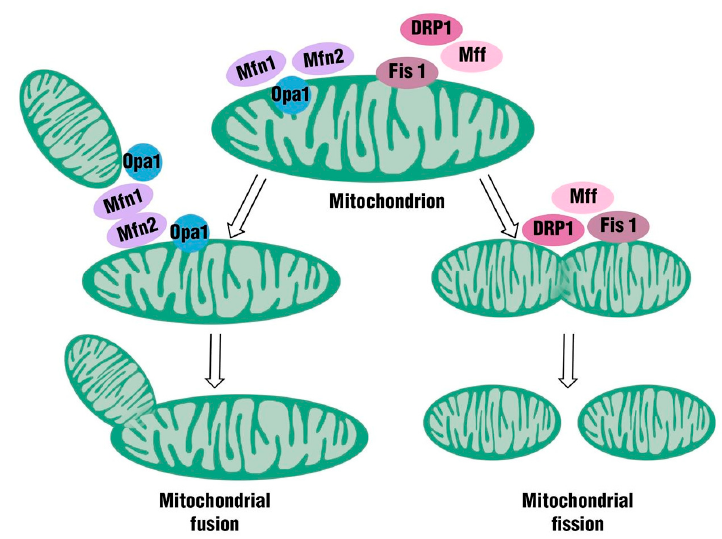
Figure 1. Mitochondria are important organelles for maintaining the normal physiological function of tissue cells; they are able to change their shape and distribution, undergoing either fission or fusion.